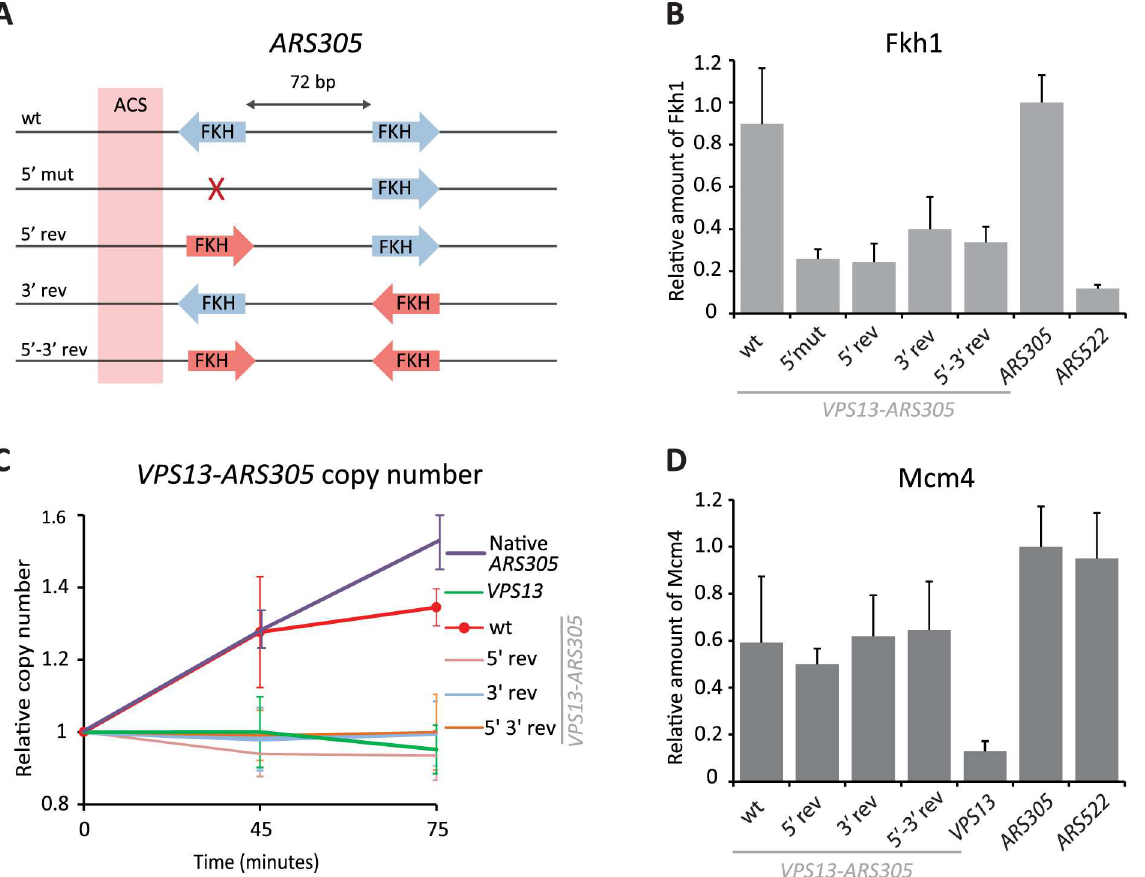
Fig 2. Alterations of Fkh1/2 site orientations in ARS305 .(A) Schematic representation of ARS305 origins inserted into the GAL - VPS13 locus. Approximate locationsof Fkh1/2 consensusbindingsites (blue arrows) and the ACS (pink box) are indicated.In 5’mut construct, the ACS-proximal Fkh1/2 site was disrupted by mutation (red X). In Fkh1/2 site reversal mutants, the sites were inverted relativeto their originalorientations (red arrows). (B) Fkh1 bindingto ARS305 loci with various orientations of Fkh1/2 sites as determined by ChIP assay. Fkh1 occupancyto ARS305 mutants is shown relative to its bindingto the native ARS305 locus. Fkh1 bindingto the native late-replicating origin ARS522 is shown as control ( ARS522 ). (C) Relative copy numberof VPS13 - ARS305 DNA in HU-arrested cells. Cells were arrested in G1 with α -factor and then releasedinto HU-containingmedia for 45 and 75 minutes. Graphs show the ratio of VPS13 - ARS305 and late-replicating ARS522 loci, the ratio in G1-arrested cells was set as 1. Relativecopy numberof the native ARS305 and origin-free VPS13 loci are shown as controls. Full data for each strain is shown in S2 Fig. (D) Mcm4 bindingto ARS305 loci with variousorientationsof Fkh1/2 sites as determined by ChIP assay. Mcm4 occupancyto mutant ARS305 is shown relativeto its bindingto the native ARS305 locus. The strain with no ARS in the VPS13 locus and the native origin ARS522 are shown as controls ( VPS13 and ARS522 , respectively).